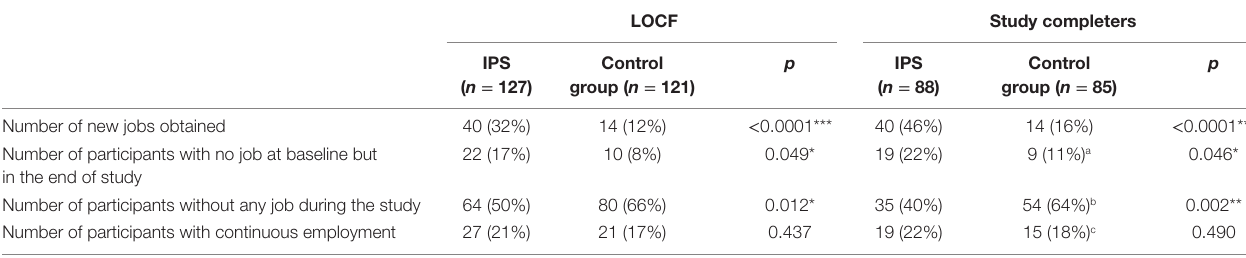
TaBle 2 | employment in the yourse of the study.